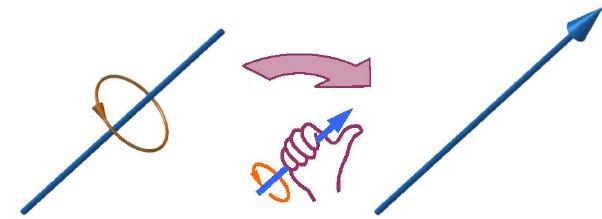
Figure 22: Equivalence between outer and inner orientations of a vector, in right-handed coordinates.